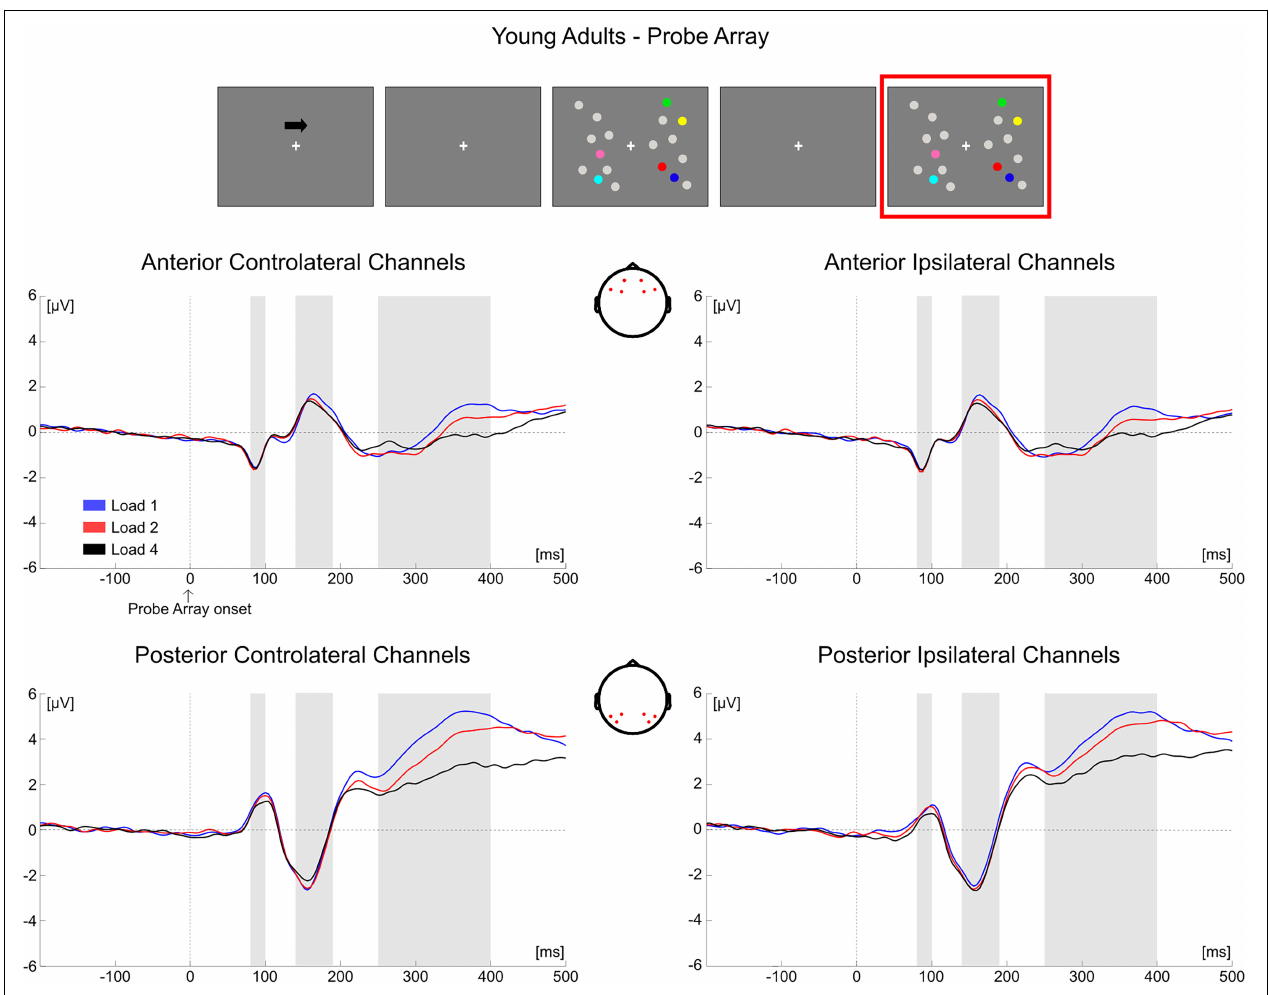
FIGURE 10 | Grand average waveforms as a function of target load over the anterior (Fp1/2, F3/4, F7/8) and posterior ROI (P7/8, PO7/8, P3/4), separately for contra- and ipsilateral to target channels, in the Younger group during item comparison. Topographies highlight the channels included in the ROIs and gray squares indicate the TOIs over which the mean amplitudes were